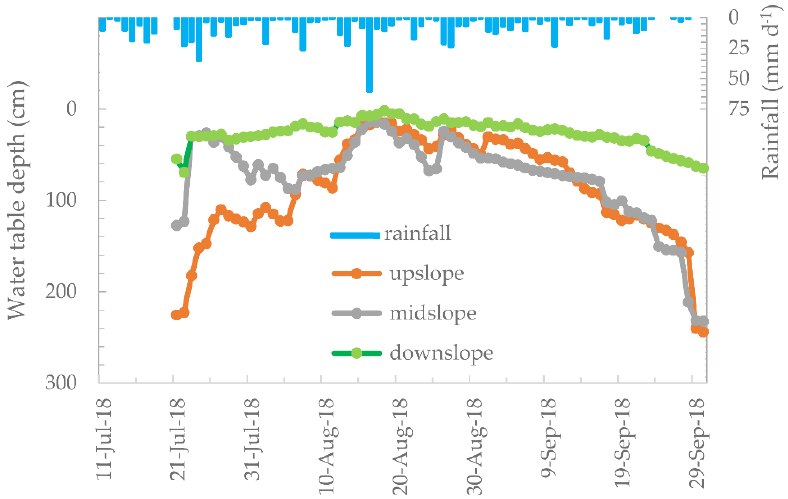
Figure 6. Average groundwater table depth for the upslope, midslope, and downslope positions of the Debre Mawi watershed in the 2018 rain phase. The water table measurements started on 22 July 2018.